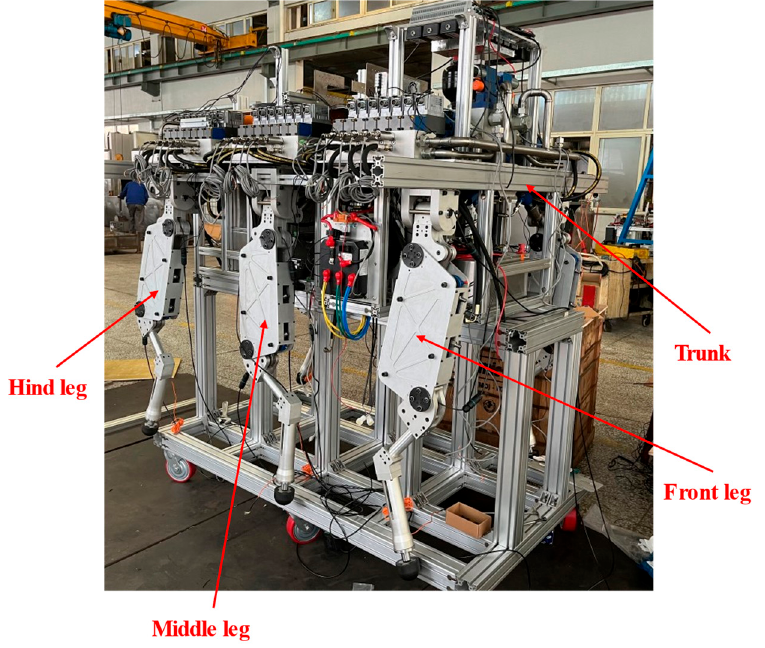
Figure 1. The hydraulic hexapod robot ZJUHEX01.